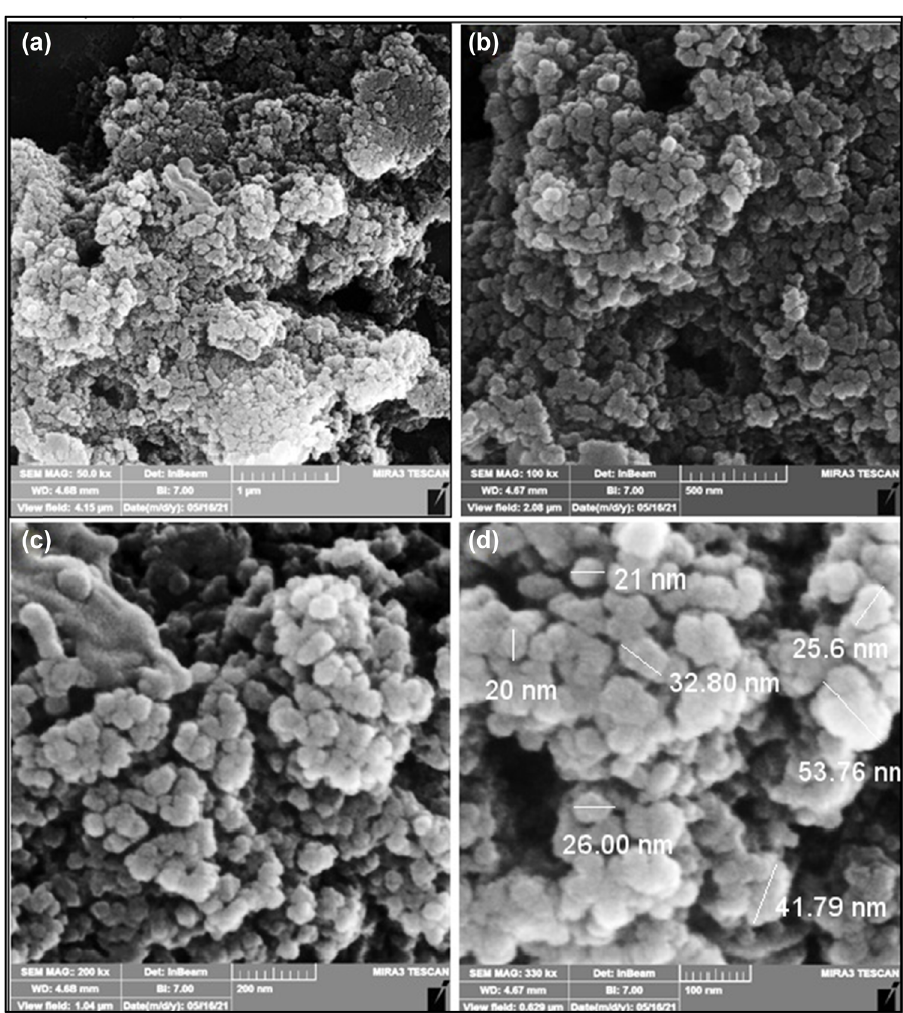
Figure 2: FESEM micrographs of IONPs at di ff erent magni fi cation; scales: ( a ) 1 µm, ( b ) 500 nm, ( c ) 200 nm, and ( d ) 100